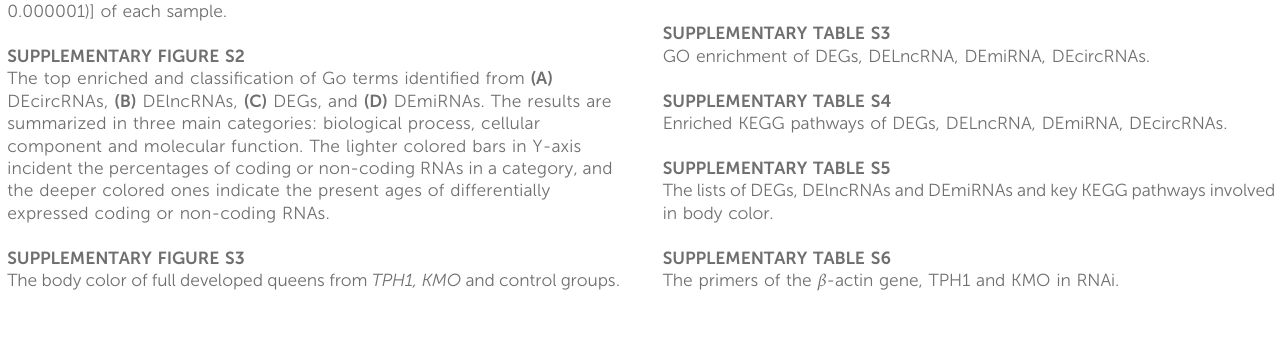
SUPPLEMENTARY TABLE S2 The list of DEGs, DELncRNA, DEmiRNA, DEcircRNAs. SUPPLEMENTARY TABLE S3 GO enrichment of DEGs, DELncRNA, DEmiRNA, DEcircRNAs.